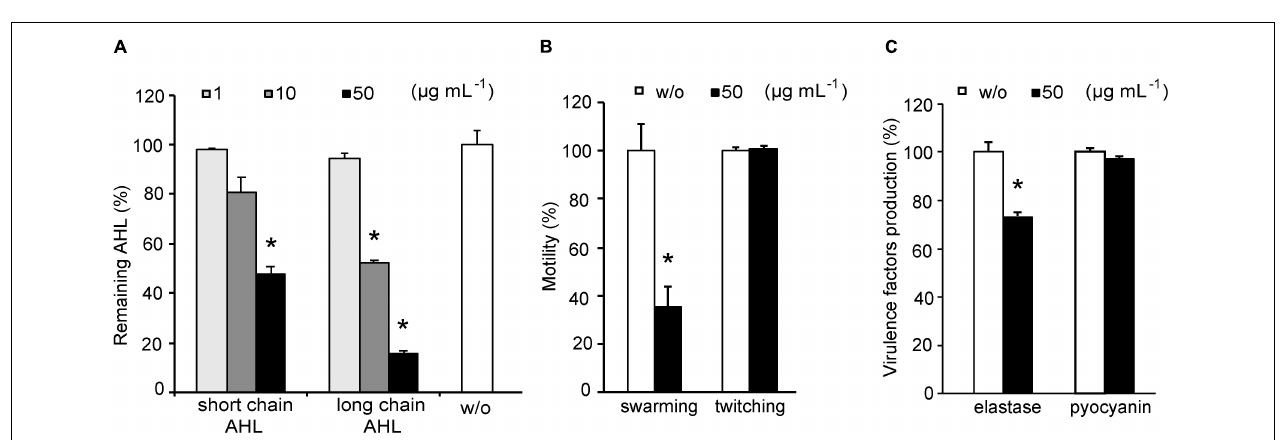
FIGURE 3 | Characterization of YtnP-ZP1. Enzyme specificity (A) and the effects of temperature (B) , pH (C) , metal ions (D) , pre-incubation temperature (E) on lactonase activity and the rate of 3-oxo-C12-HSL hydrolysis (F) . w/o, control reaction without metal ions; control, reaction with enzyme without pre-incubation. Values are representative of three independent experiments ± SD. * P < 0.05.